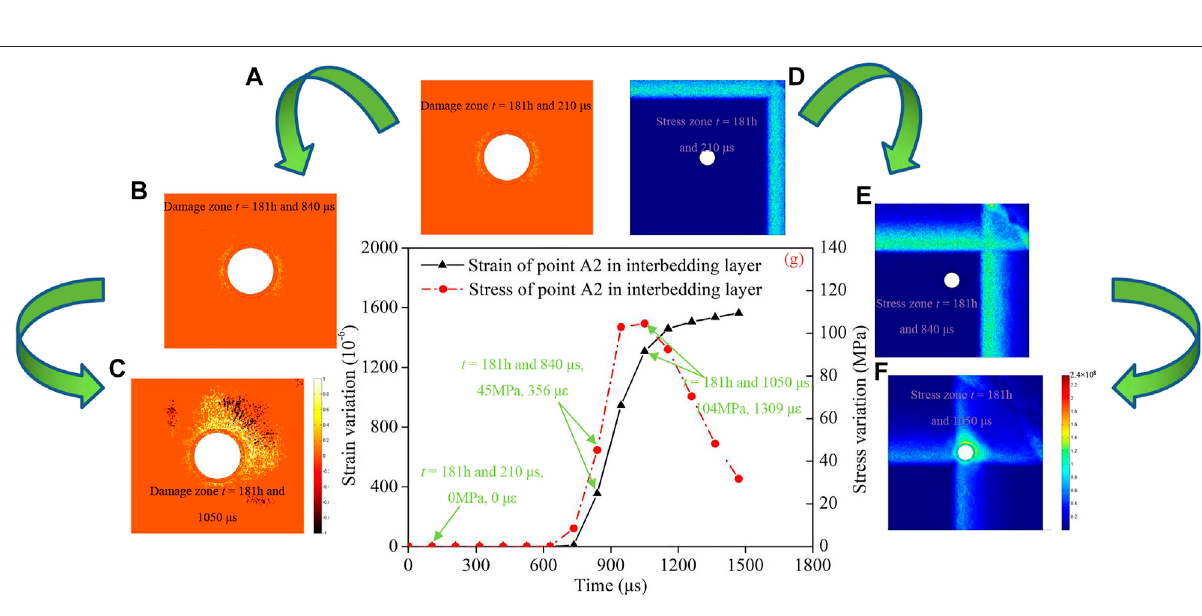
FIGURE 9 | The numerical results of a rheological shaft with dynamic disturbance. (A – C) Distribution of the damage area of the surrounding rockmass of a shaft; (D – F) Distribution of the stress area of the surrounding rockmass of a shaft; (G) Deformation and stress law the surrounding rockmass points A2 of a shaft.